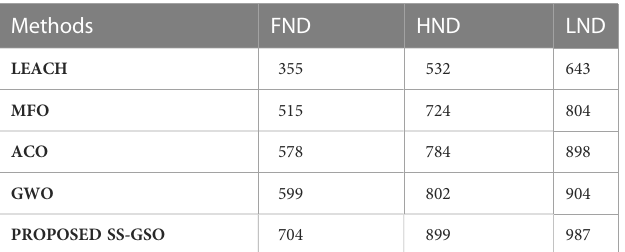
TABLE 3 Network lifespan analysis of various algorithms.